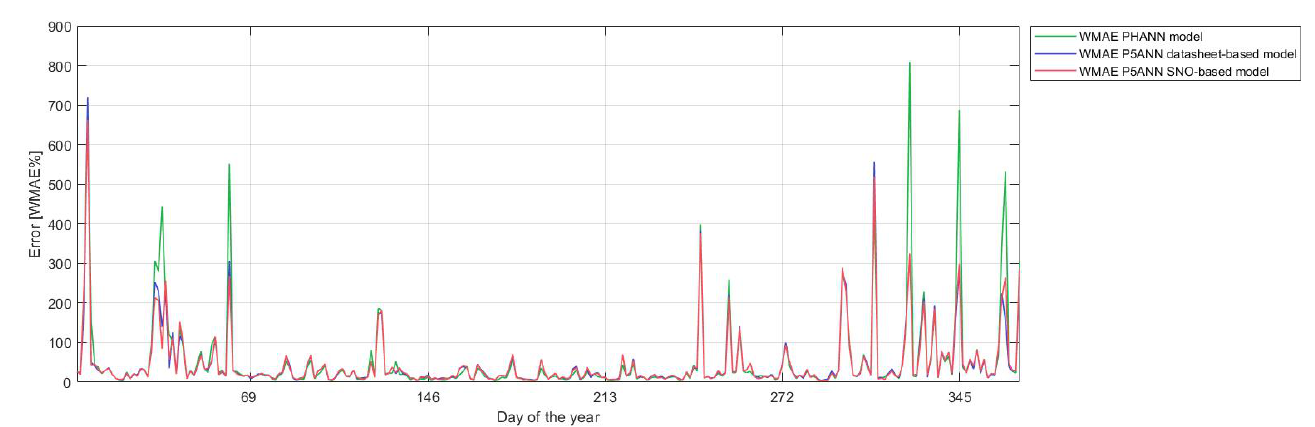
Figure 10. WMAE comparison between the three ANN-based hybrid models.